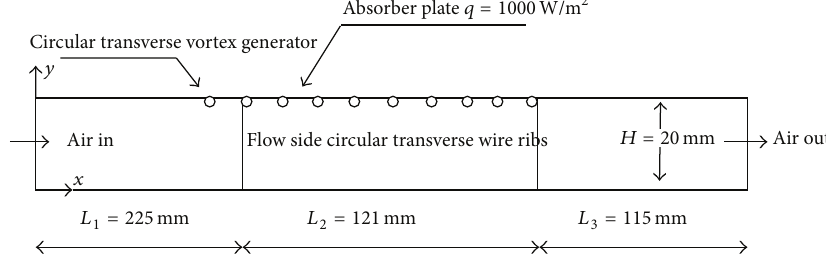
Figure 1: Schematic of two-dimensional solution domain for CFD analysis.